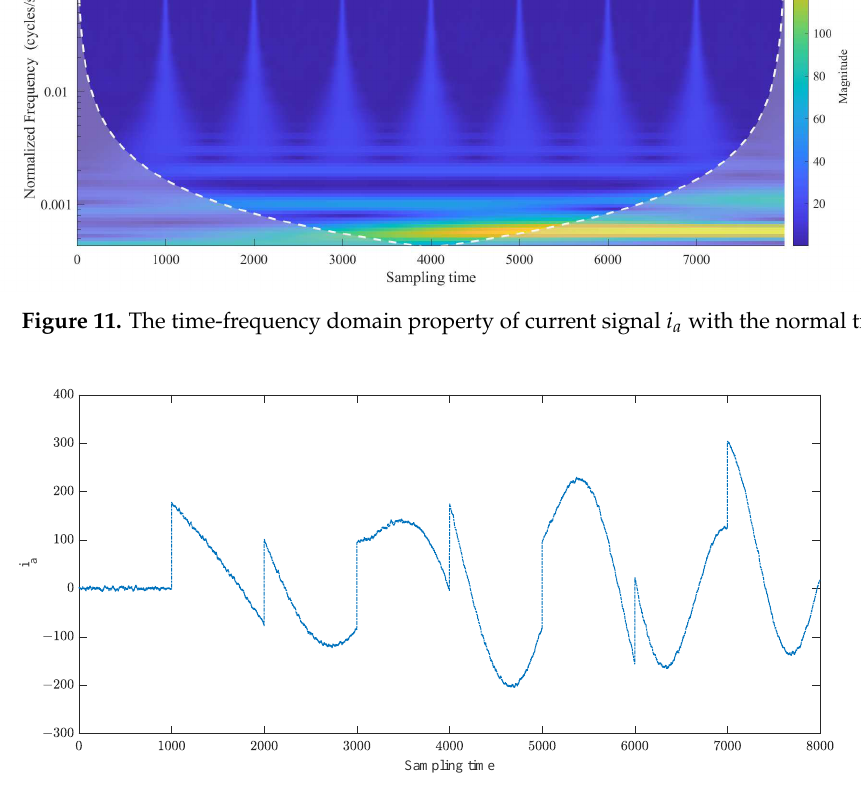
Figure 12. The current signal i a with FNR